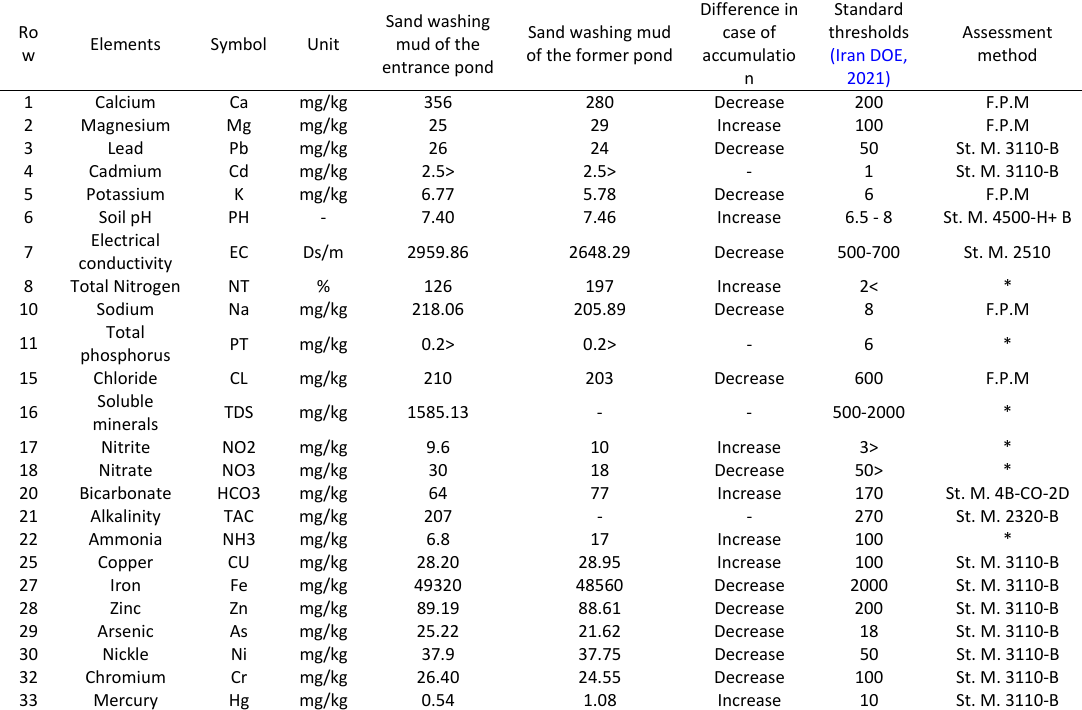
Table 7: The average concentration of various elements in the sand washing mud samples obtained from the old and new ponds in Aab'Ali Landfill (Ahyaei and Behbahanizadeh, 1993) Ro